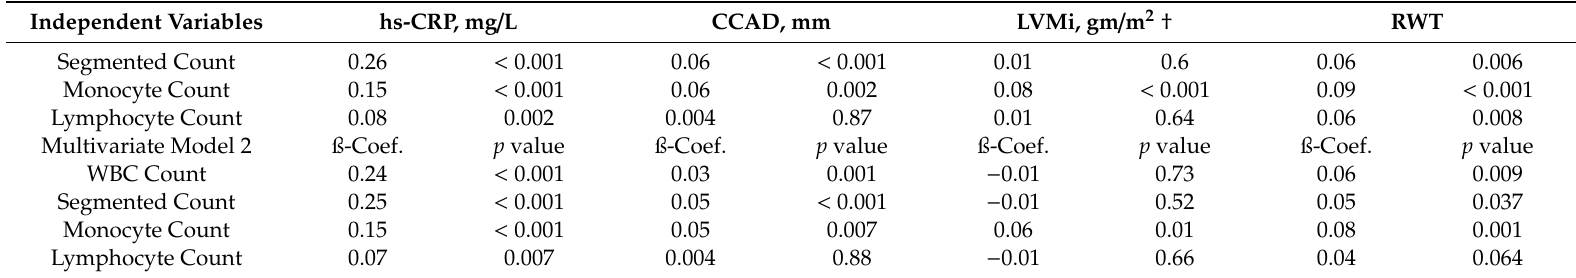
Abbreviations as Table 1. Model 1: adjusting for age, sex, and BMI. Model 2: adjusting for age, sex, BMI, systolic blood pressure, cholesterol, HDL, and medical history of hypertension, diabetes, cardiovascular disease, and estimated glomerular filtration rate (eGFR). † BMI was not included in the multivariate models. Table 3. Stepwise multivariate Cox regression models for the composite endpoints of heart failure (HF) and all-cause